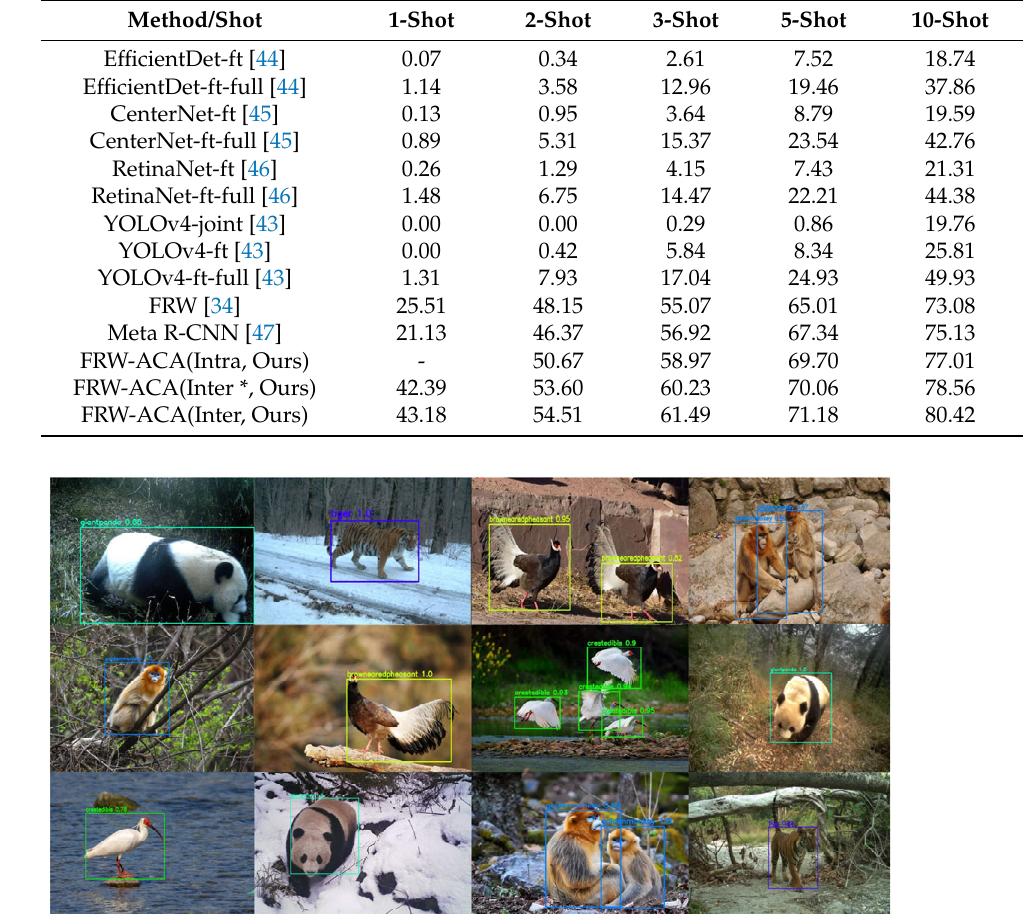
Table 1. Few-shot detection performance (mAP) on the endangered-animal categories of the EAOD. (* indicates remove spatial constraints in the mixture).